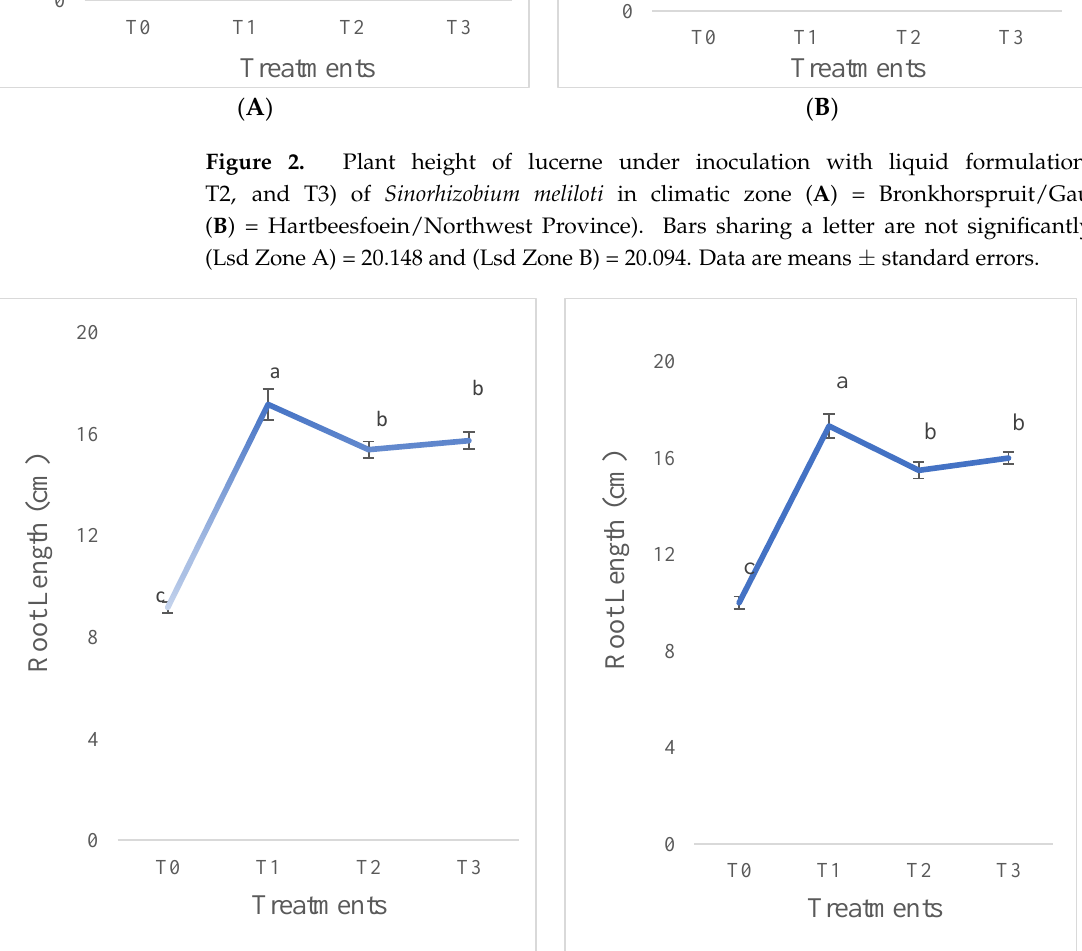
Figure 2. Plant height of lucerne under inoculation with liquid formulation (T0, T1, T2, and T3) of Sinorhizobium meliloti in climatic zone ( A ) = Bronkhorspruit/Gauteng and ( B ) = Hartbeesfoein/North- west Province). Bars sharing a letter are not significantly different (Lsd Zone A) = 20.148 and (Lsd Zone B) = 20.094. Data are means ± standard errors.